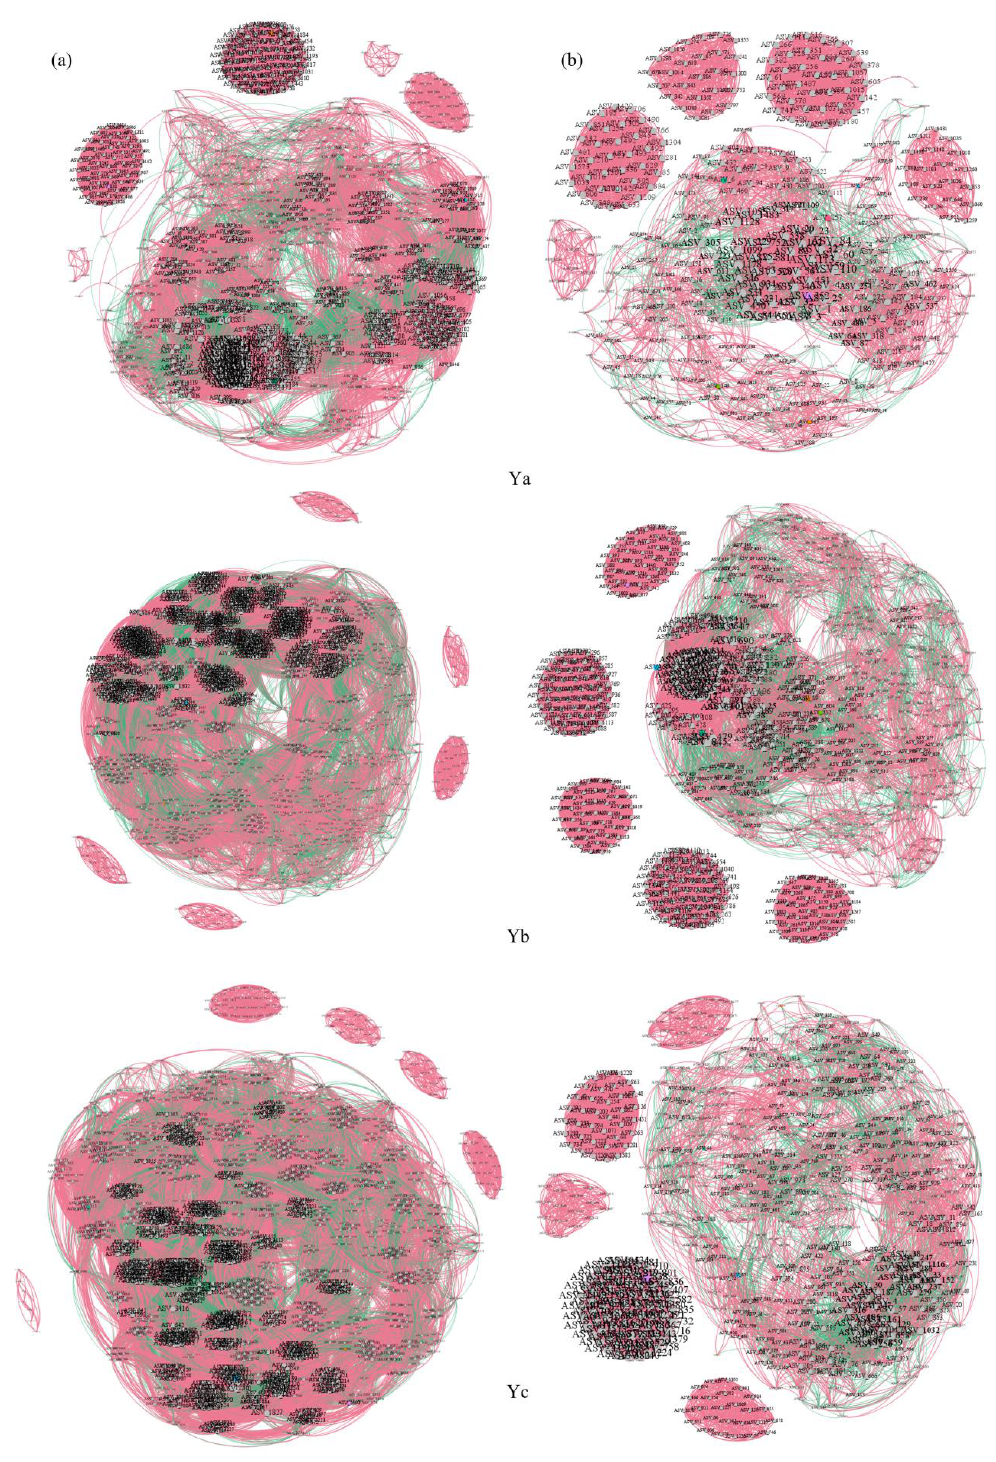
Figure 6. Network interactions of phyllosphere bacterial ( a ) and fungal ( b ) OTUs. Each node represents an OTU, and the colors of the nodes indicate different phyla. The OTUs were separated into different modules, shown as circles, by the greedy modularity optimization method. Ya: healthy Pinus tabuliformis trees; Yb: diseased P. tabuliformis trees at an early stage of B. xylophilus infection; Yc: diseased P. tabuliformis trees in the last